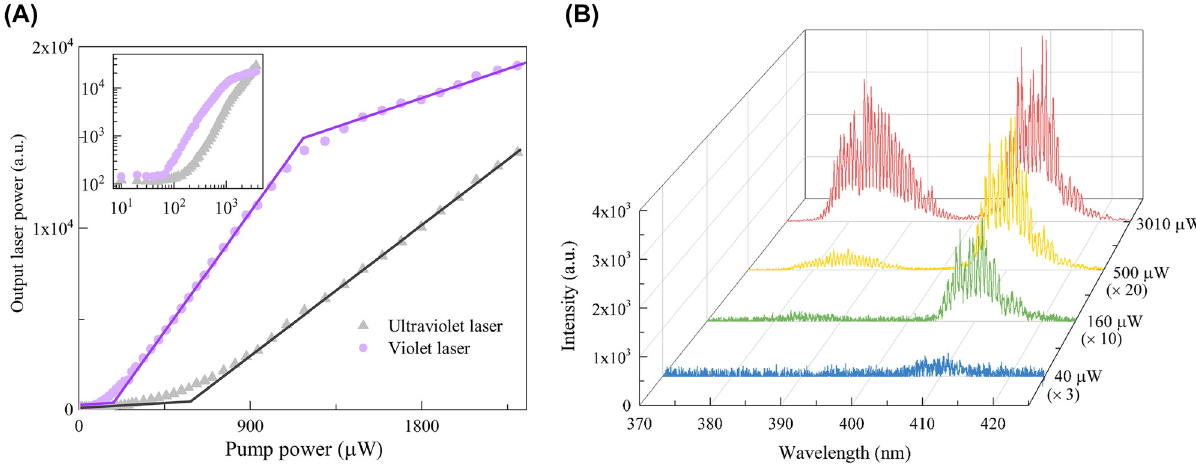
Figure 2: Lasing characterizations. (A) Emission intensities of ultraviolet and violet lasers versus the pump power in linear scale. The inset shows the plot in log–log scale. Their emission intensities are integrated from 375 to 395 nm and 400 to 425 nm, respectively. (B) Lasing spectrum evolution with the increased pump power.